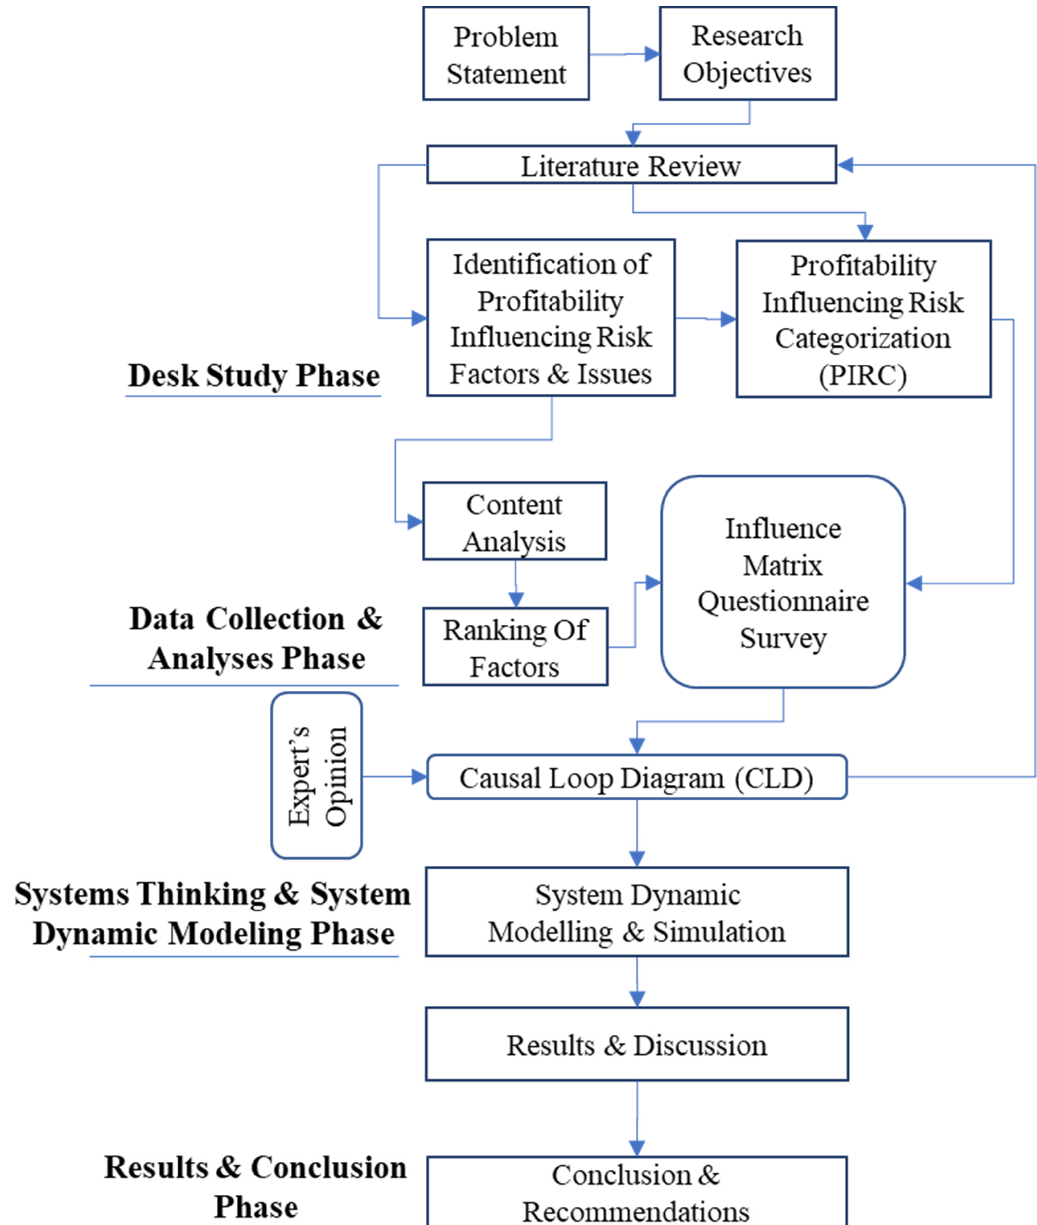
Figure 1. Schematic demonstration of methodology.